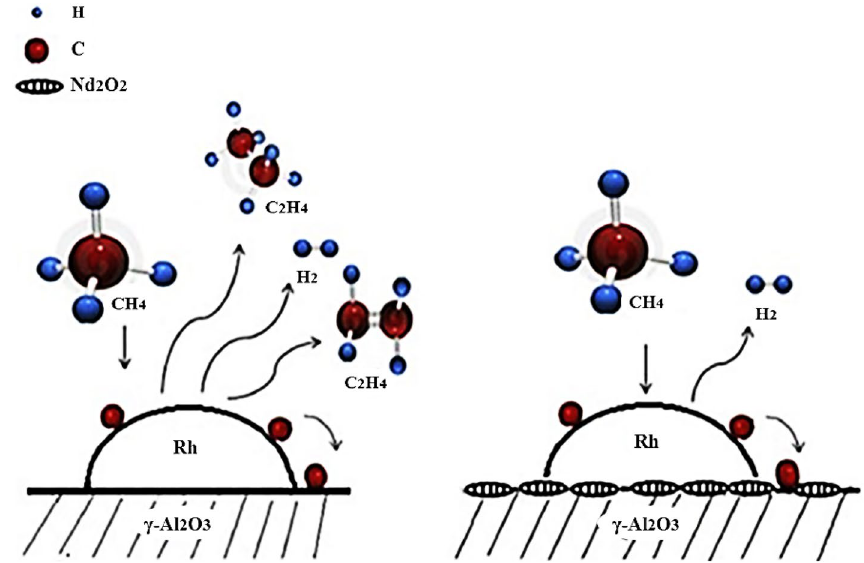
Fig. 8 Representation of the behavior of methane decompo- sition on Rh metallic particles for a Rh/Al 2 O 3 and b Rh/Al 2 O 3 - 10 wt% Nd 2 O 3 catalysts